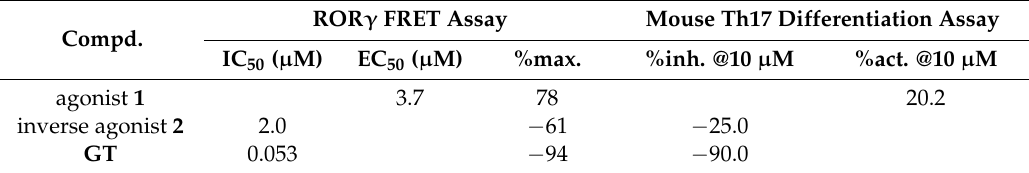
Table 1. Results in FRET assay and Th17 cell differentiation assay a .